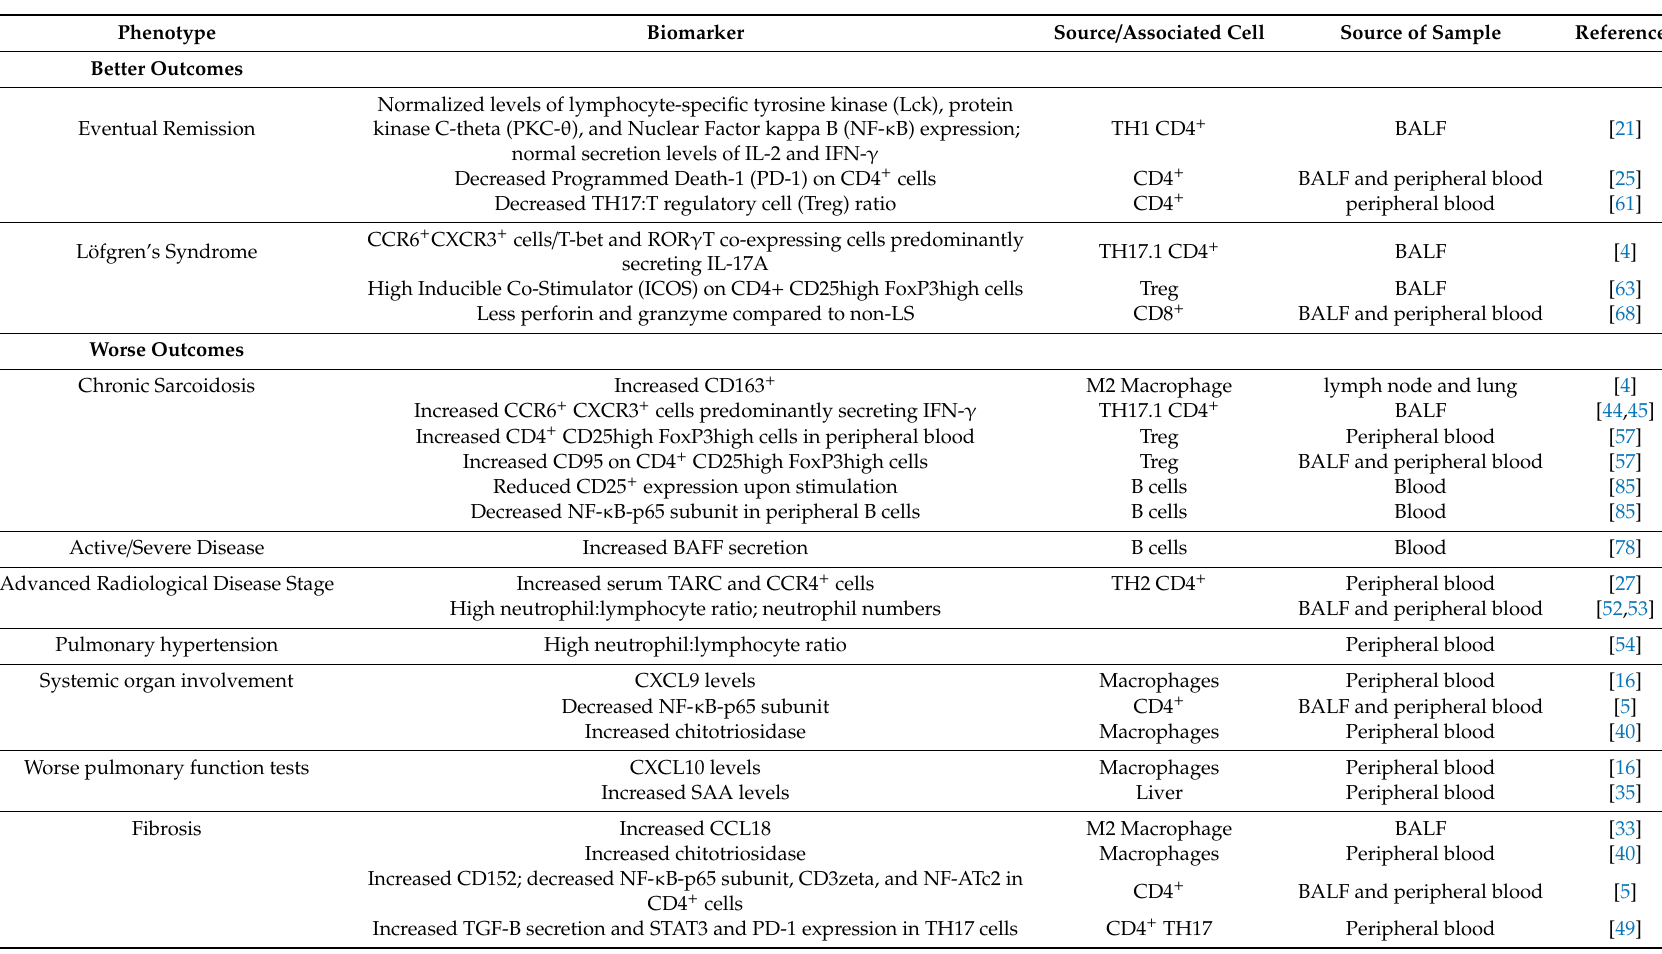
Table 1. Sarcoidosis biomarkers. Most of the novel biomarkers examined in sarcoidosis have not been clinically validated nor are su ffi ciently specific or sensitive to be used in isolation for clinical-decision making. However, several sarcoidosis biomarkers have important roles in the clinical management of sarcoidosis when used in combination with clinical data including the results of other